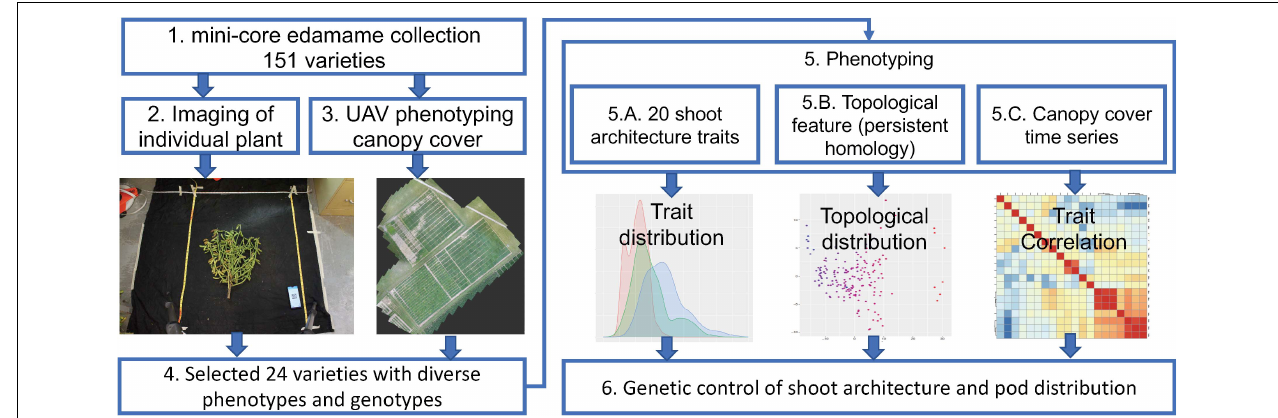
FIGURE 1 | Workflow of phenomics analysis of edamame shoot architecture and canopy cover. Step 1. Data from a mini-core collection of edamame varieties were used for this study. Step 2. Individual plant was imaged twice on a black background. Step 3. Unmanned aerial vehicle was used to collect canopy cover data over the growth season. Step 4. Selected varieties were used for detailed characterization of the shoot architecture. Step 5. Phenotypic data analyses were performed. Step 6. Potential genetic control points of shoot architecture were